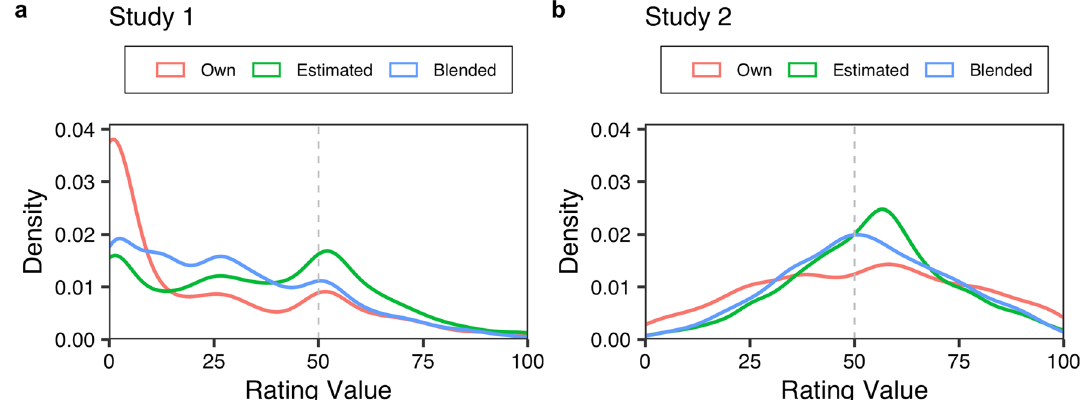
Figure 3. Data structure in Study 1( a ) and Study 2( b ). Each line represents a probability density function. In Study 1, not all opinion types followed a normal distribution ( Kolmogorov–Smirnov test: ps < 0.001), while in Study 2, they did ( ps > 0.1).